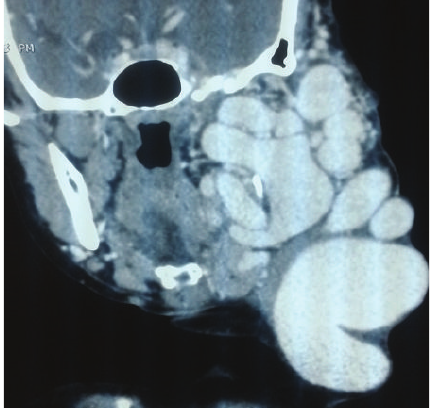
Figure 1: Anterolateral view of the cervical AVM.